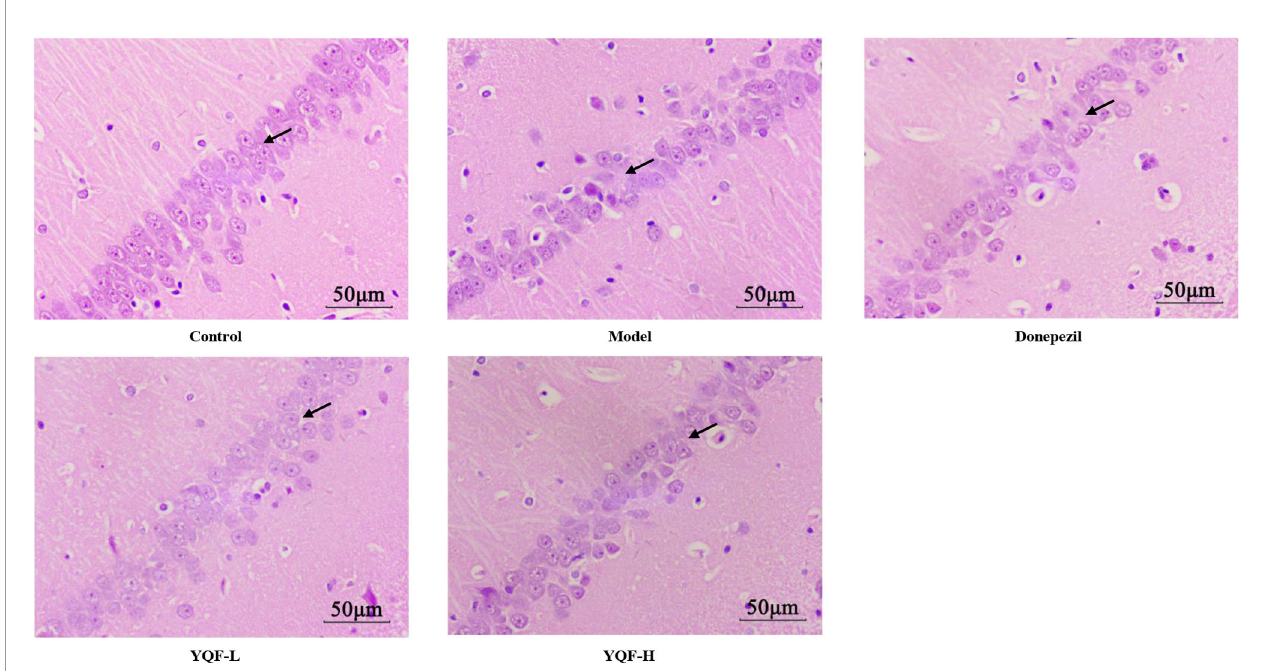
FIGURE 2 | HE staining of hippocampal CA1 (n =